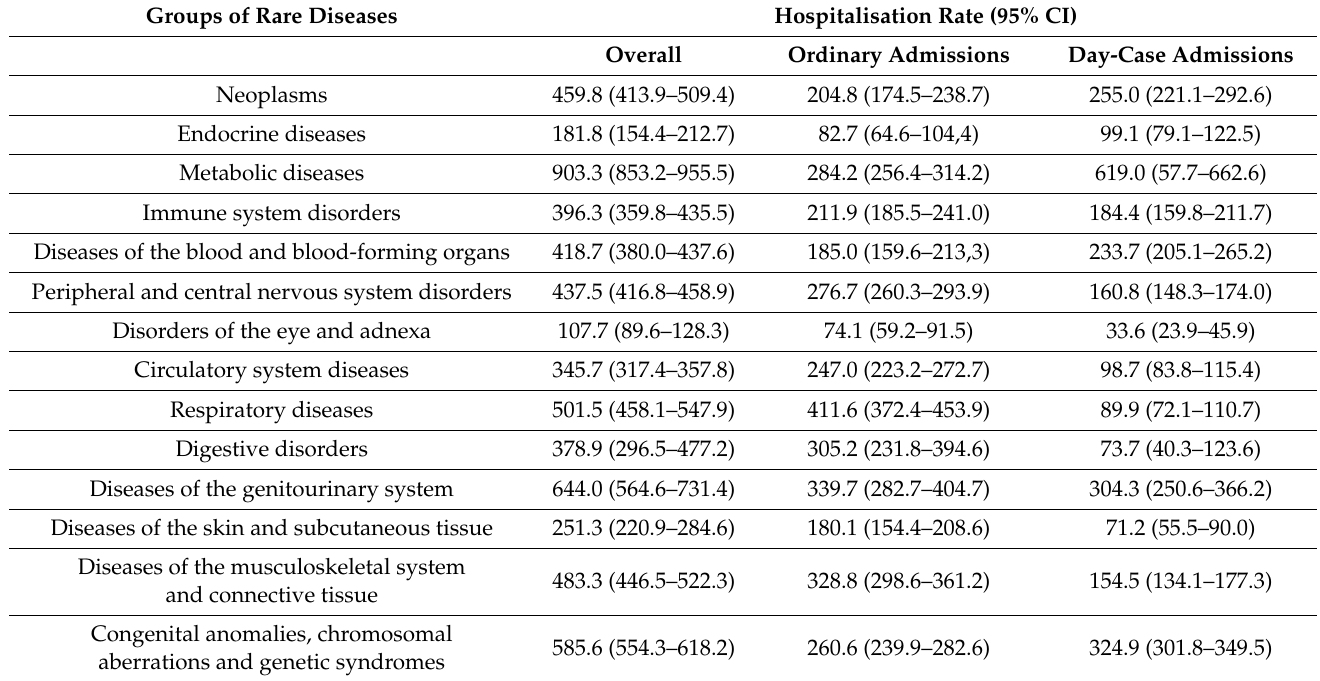
Table 3. Hospitalisation rate (per 1000 cases), overall, by type of admission, and by group of rare